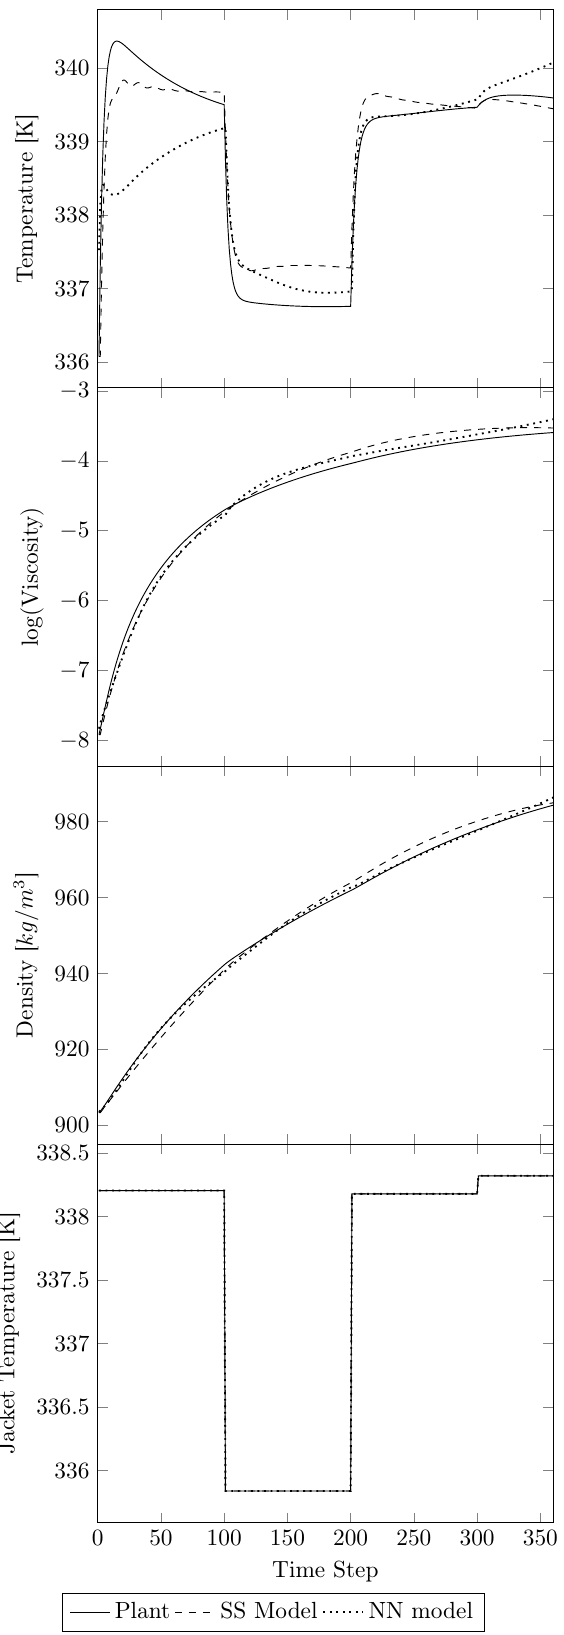
Figure 6. Validation of state-space models and NARX networks in the absence of measurement noise and using distinctly generated input